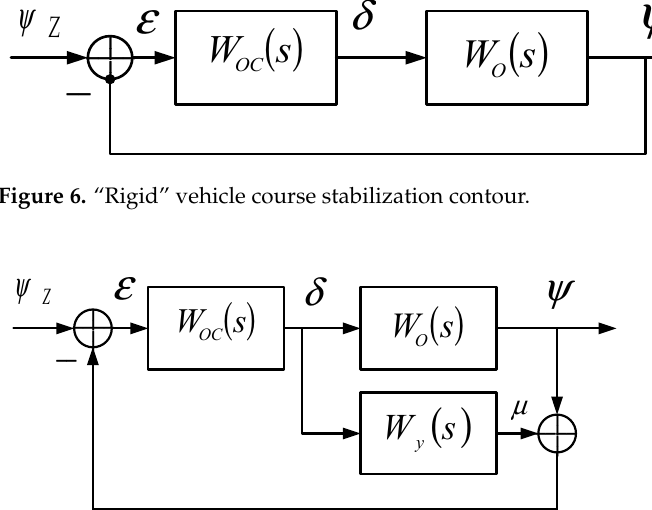
11 of 21 Figure 5. Block diagram of a one-dimensional model of the course stabilization system (“model 3”). Finally, neglecting the elastic constraints in “model 2”, we obtained “model 4”. Its structural diagram is identical to the structural diagram shown in Figure 4, at 0)( = sW y H ψδ . Synthesis and analysis of complex multiloop UAV stabilization systems with specific signs of complexity are carried out following the given hierarchy of models. Let us consider the application of the proposed approach, for example, for analyzing